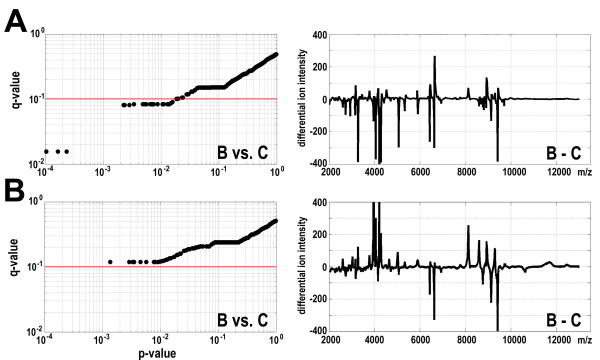
Changes in serum proteome patterns specific for subgroups of patients. A - Analysis of the group of patients subjected to surgery and adjuvant therapy. B - Analysis of the group of patients subjected only to surgery. Left - the q-values are plotted against the p-values of differences between samples B and C; each dot represents one spectral component, the red horizontal line represents a q-value cut-off equal to 0.1. Right - average differential spectra for samples B and C.